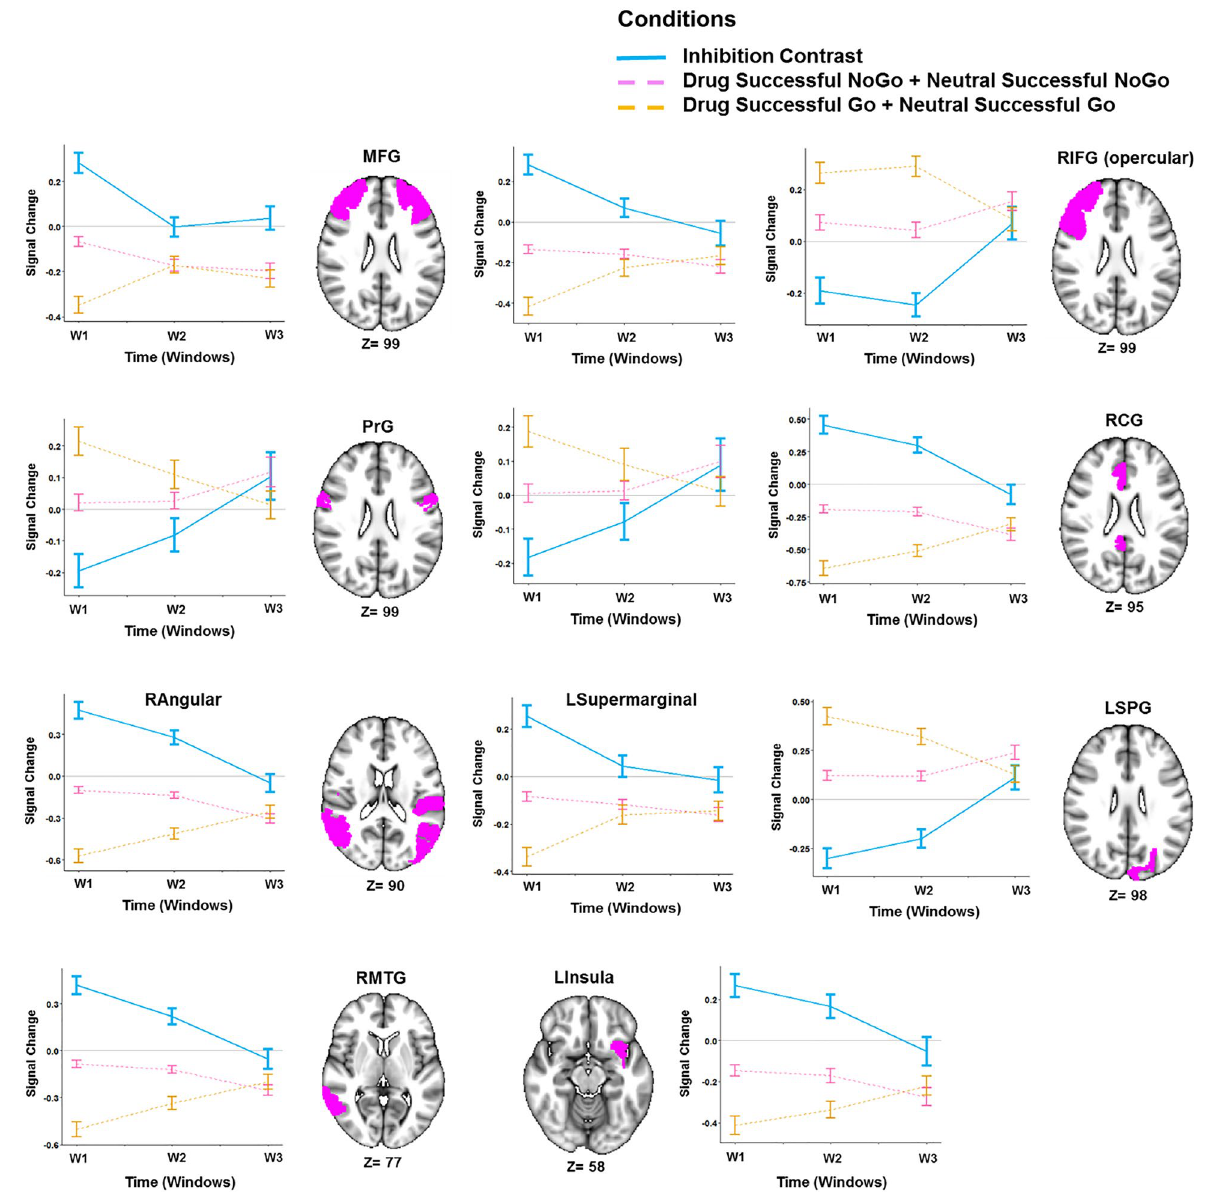
Figure 4. Temporal behavior of ROIs with significant condition by time interactions in the response inhibition linear mixed effects (LME) model. Lines show the average main effect of NoGo (Drug Successful NoGo + Neutral Successful NoGo) or Go (Drug Successful Go + Neutral Successful Go) inhibition condition in the Brainnetome (BNA) regions or the result of Go vs. NoGo contrast, and error bars show the standard error of z-statistic values across 53 methamphetamine use disorders (MUD) at each temporal window (FDR corrected p- value < 0.001). The graphs were implemented and visualized using R software version 3.6.2 (https:// www.r- proje ct. org/). 3D brains were visualized using FSLeyes, the FSL image viewer (https:// open. win. ox. ac. uk/ pages/ fsl/ fsley es/ fsley es/ userd oc/ insta ll. html). MFG middle frontal gyrus, RIFG (opercular) right opercular part of inferior frontal gyrus, PrG precentral gyrus, RCG right cingulate gyrus, LSPG left superior parietal gyrus, RMTG right middle temporal gyrus, RAngular right angular gyrus, LInsula left